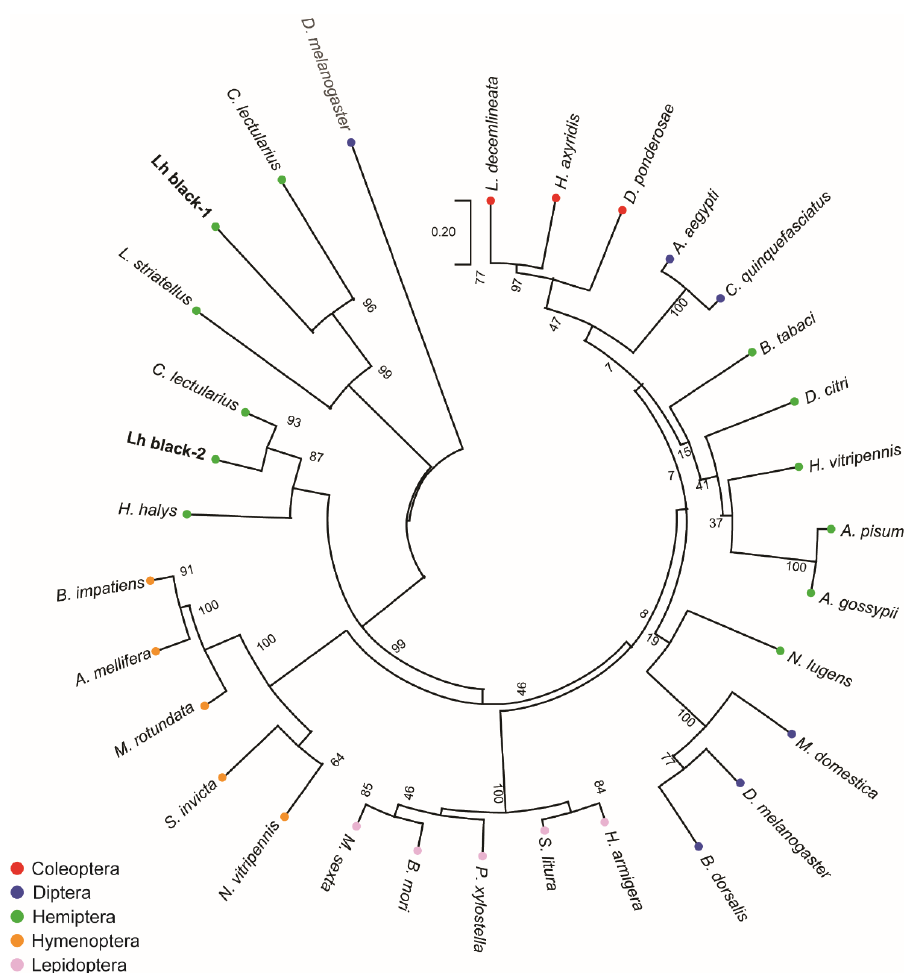
Figure 2. Phylogenetic analysis of putative black homologs in L. hesperus and other insects. The tree with the highest log likelihood ( − 14,891.07) is shown. The tree was rooted to the Drosophila melano- gaster glutamic acid decarboxylase 1 and is drawn to scale, with branch lengths measured in the number of substitutions per site. Insect orders have been color coded: Coleoptera—red; Diptera— blue; Hemiptera—green; Hymenoptera—orange; and Lepidoptera—pink. Numbers at the nodes in- dicate bootstrap support across 1000 replicates. Accession numbers for the sequences used are listed in Table S2.